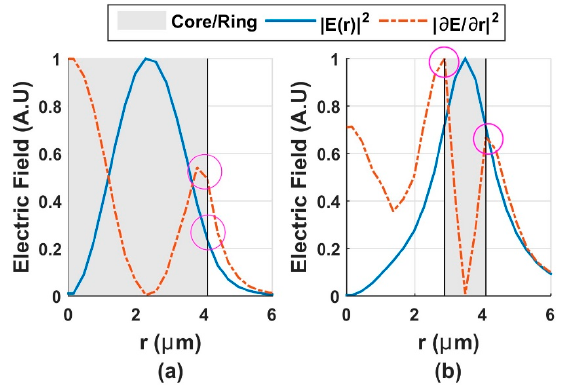
Figure 1. Normalized index profile (gray background) and corresponding mode intensity | E ( r ) | 2 and its derivate for the scalar LP 11 mode; ( a ) conventional step-index fiber and ( b ) the ring design. Circles in Figure 1 indicate the field intensity (solid line) and its derivate (dotted line) on the interface, so higher values are for the ring design presented in Figure 1b allowing to lift the degeneracy